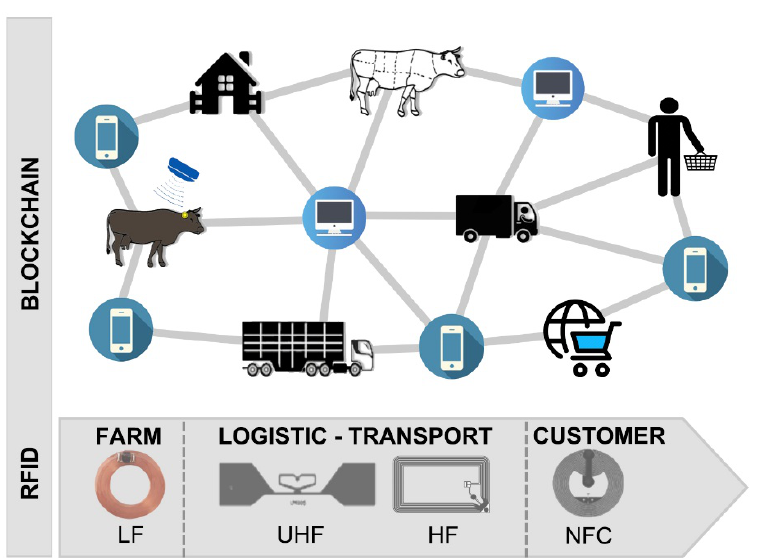
Figure 1. Example of meat supply-chain digitalisation. The Low Frequency (LF) ear-tag contains the animal code which is registered in private and public repositories. High Frequency (HF) and Ultra-High Frequency (UHF) tags identify meat cuts, and Near Field Communication (NFC) tags are used on packed meat in retail. The distributed and decentralised data infrastructure using blockchain enhances the level of trust in the traceability system.